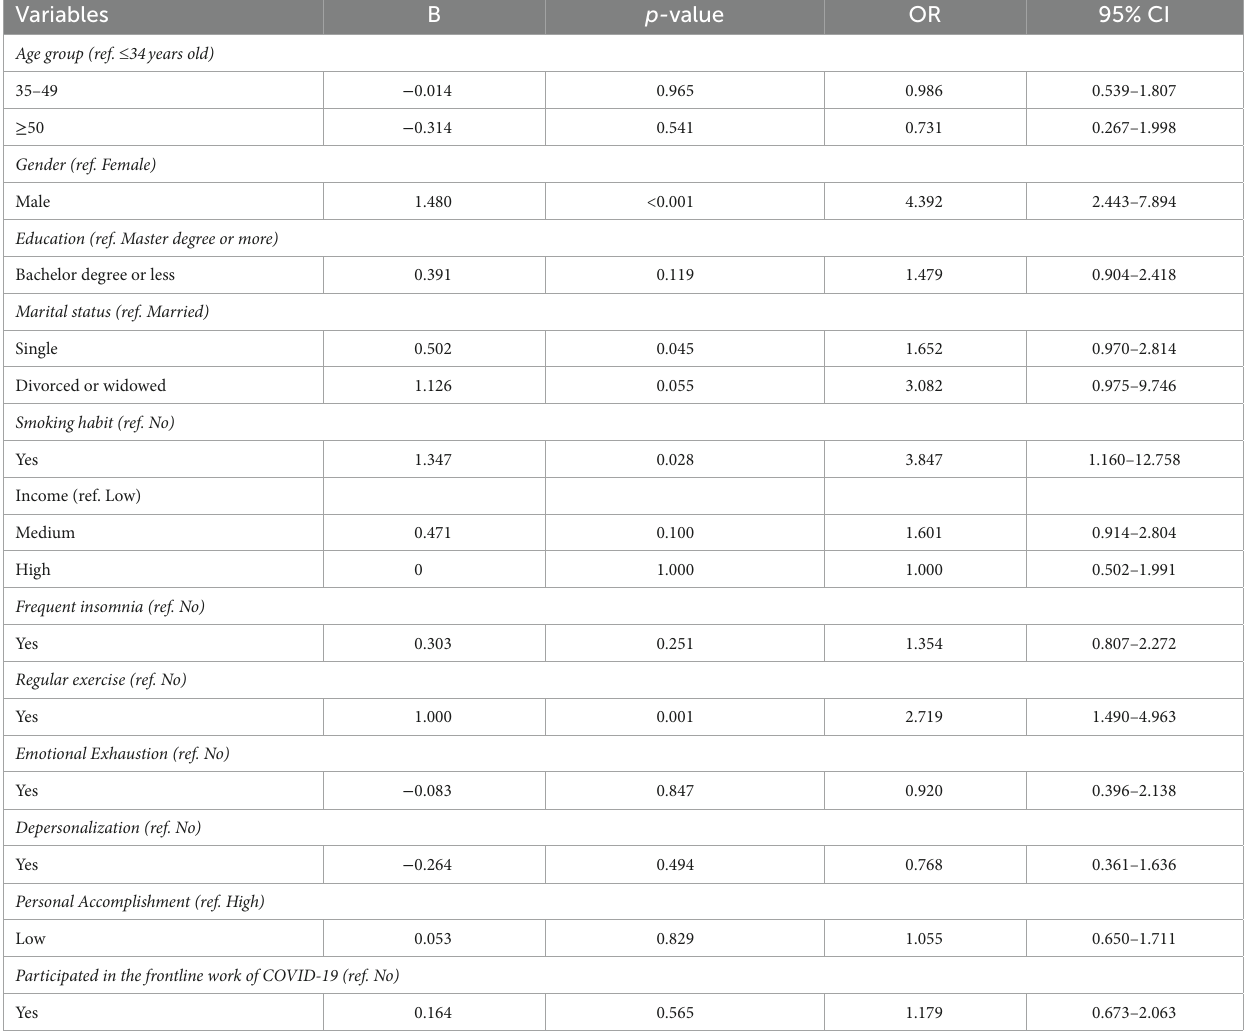
TABLE 2 Multiple logistic regression examining individual characteristics associated with alcohol use in Chinese clinical therapists.